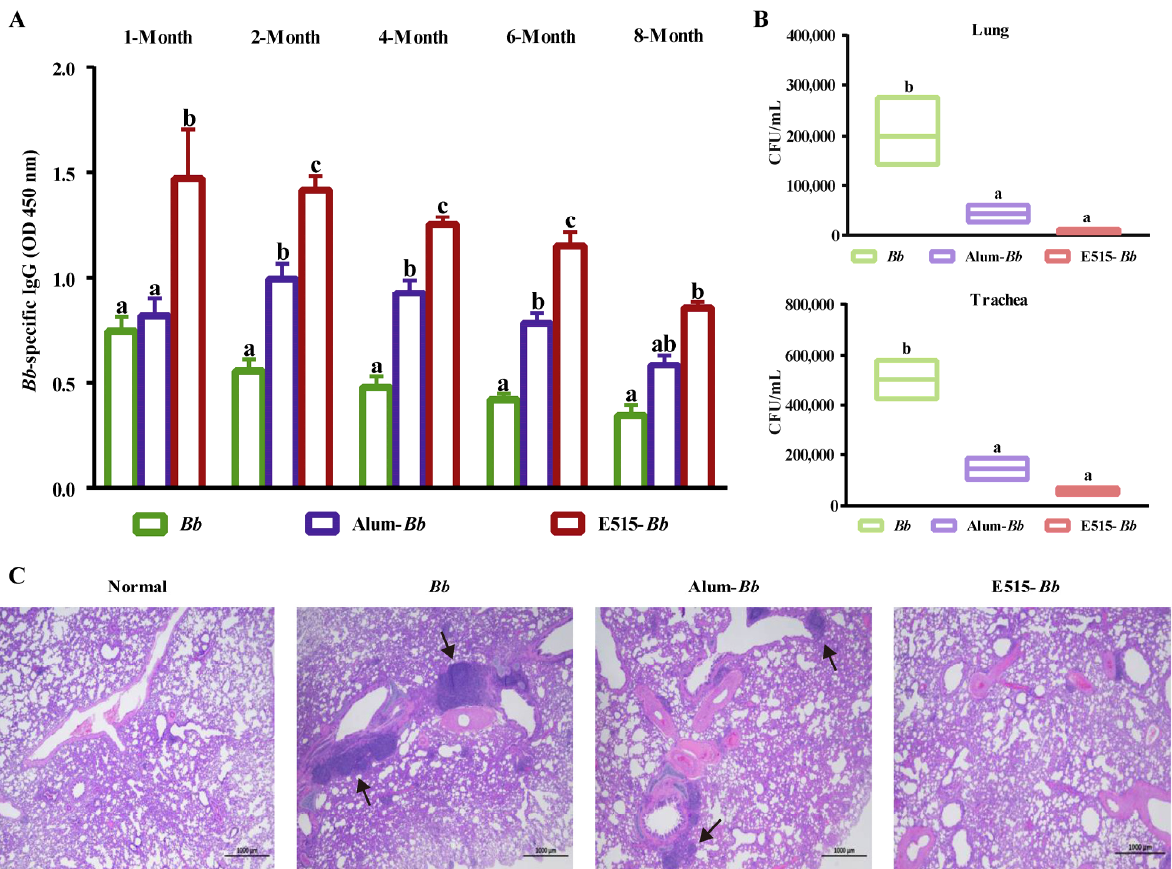
Figure 4. Evaluation of the long-term protection produced by the E515- Bb vaccine. Rabbits ( n = 12/group) were s.c. injected with 1 mL of inactivated Bb antigen (1.6 × 10 10 CFU/mL) or inactivated Bb antigen adjuvanted with E515 or Alum. Serum samples were collected 1, 2, 4, 6, and 8 months after immunization to measure Bb -specific IgG levels ( A ). Then, rabbits were challenged by ear vein injection with live Bb (2.4 × 10 10 CFU/rabbit). Seven days after infection, bacterial burdens in the lung and trachea were quantified ( n = 5) ( B ), and HE staining of lungs from infected rabbits was performed, arrows show area of inflammatory cell infiltration ( C ). Data are presented as the mean ± SE. Bars labeled with different lowercase letters (e.g., “a” and “b”) are significantly different ( p < 0.05), and bars labeled with same or common lowercase letters are not statistically different (e.g., “a” and “ab”), ( p ≥ 0.05).